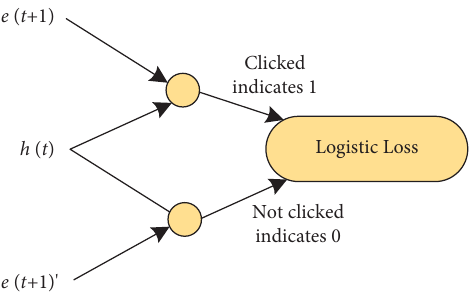
Figure 3: Structure of the auxiliary loss